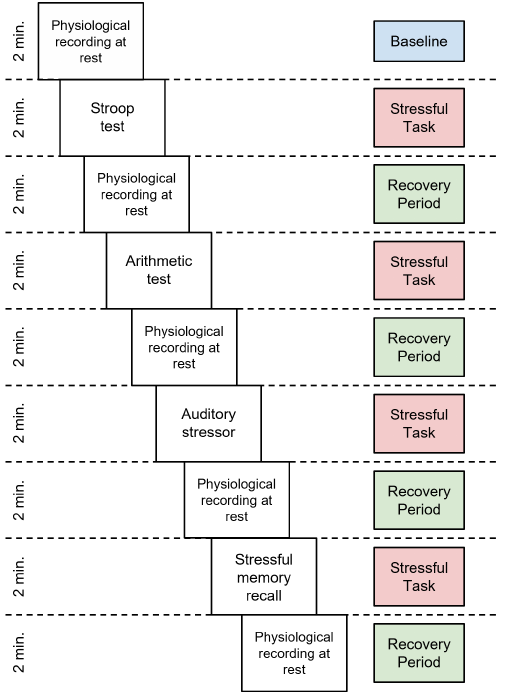
Figure 4. Chronological representation of the psychophysiological stress